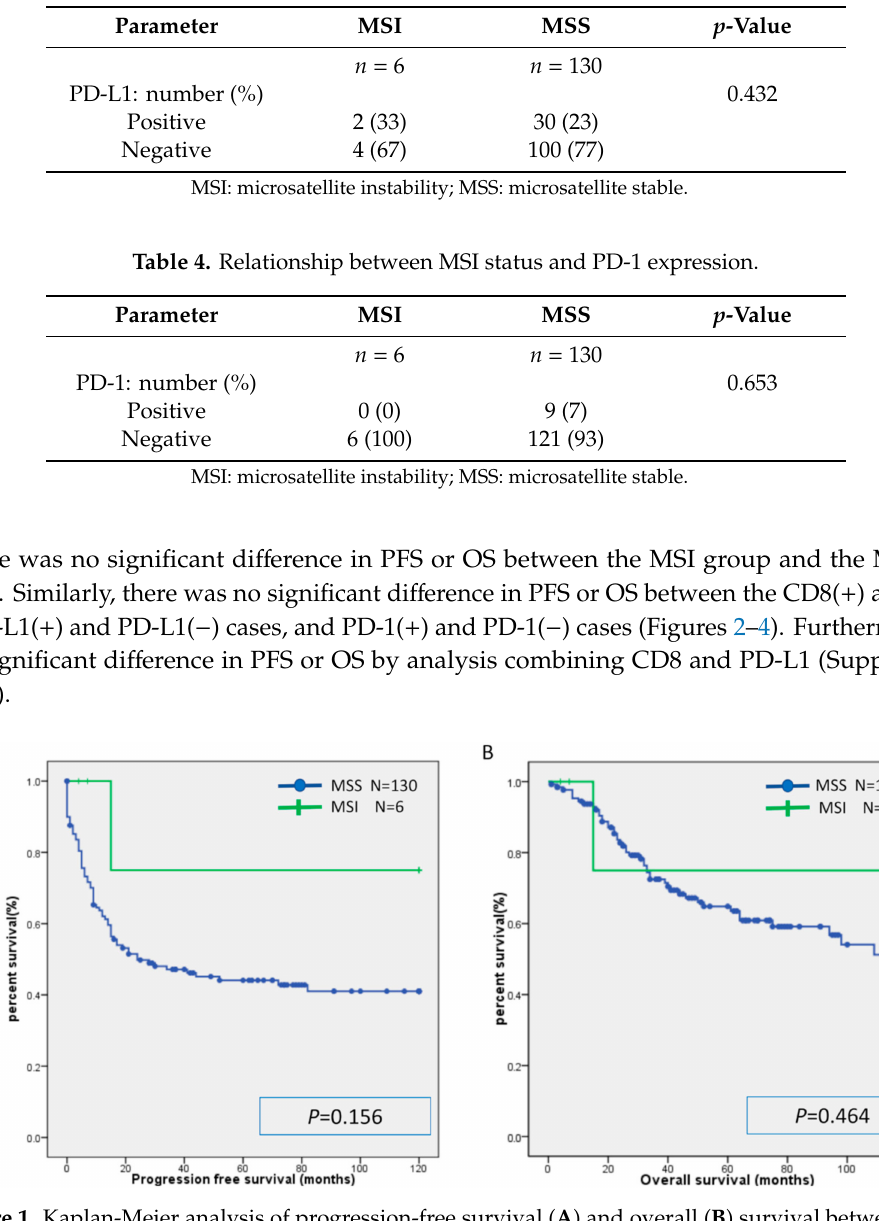
Figure 1. Kaplan-Meier analysis of progression-free survival ( A ) and overall ( B ) survival between the MSI group and MSS group. MSI: microsatellite instability; MSS: microsatellite